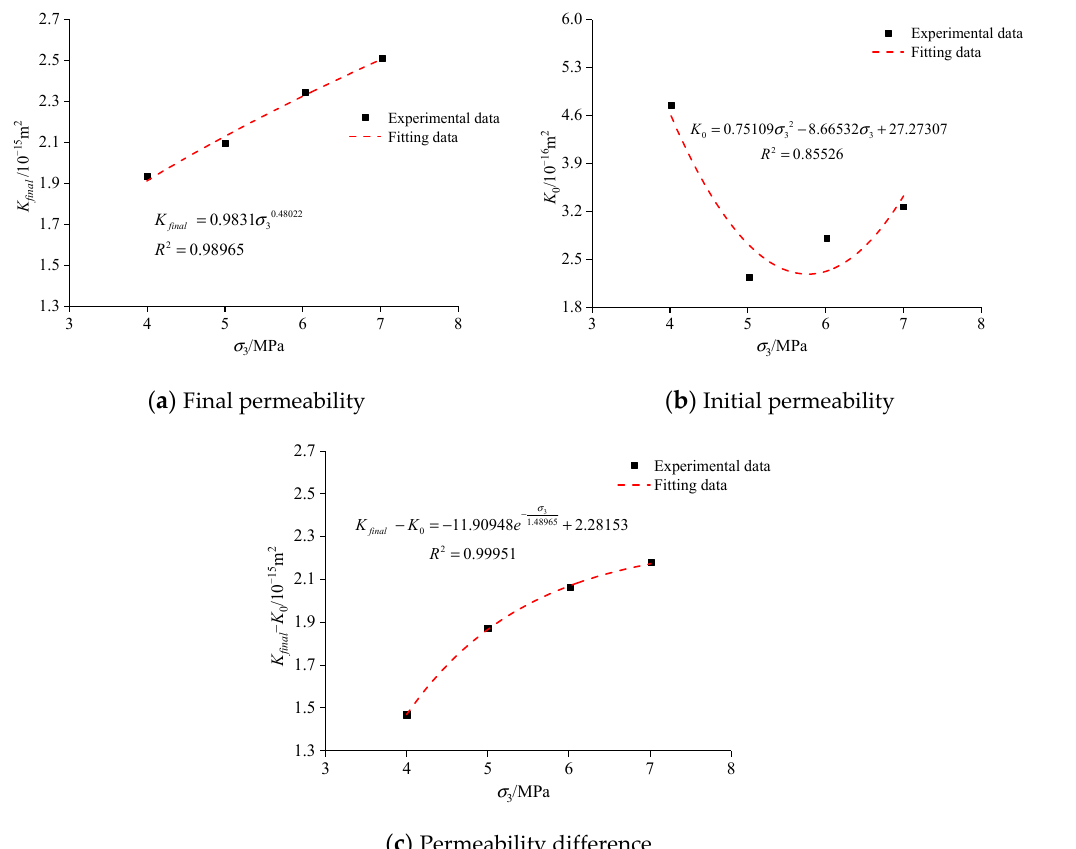
Figure 8. Permeability variations of axially unloaded coal samples under a constant GP of 1.5 MPa and different CPs: ( a ) final permeability; ( b ) initial permeability; ( c ) permeability difference.